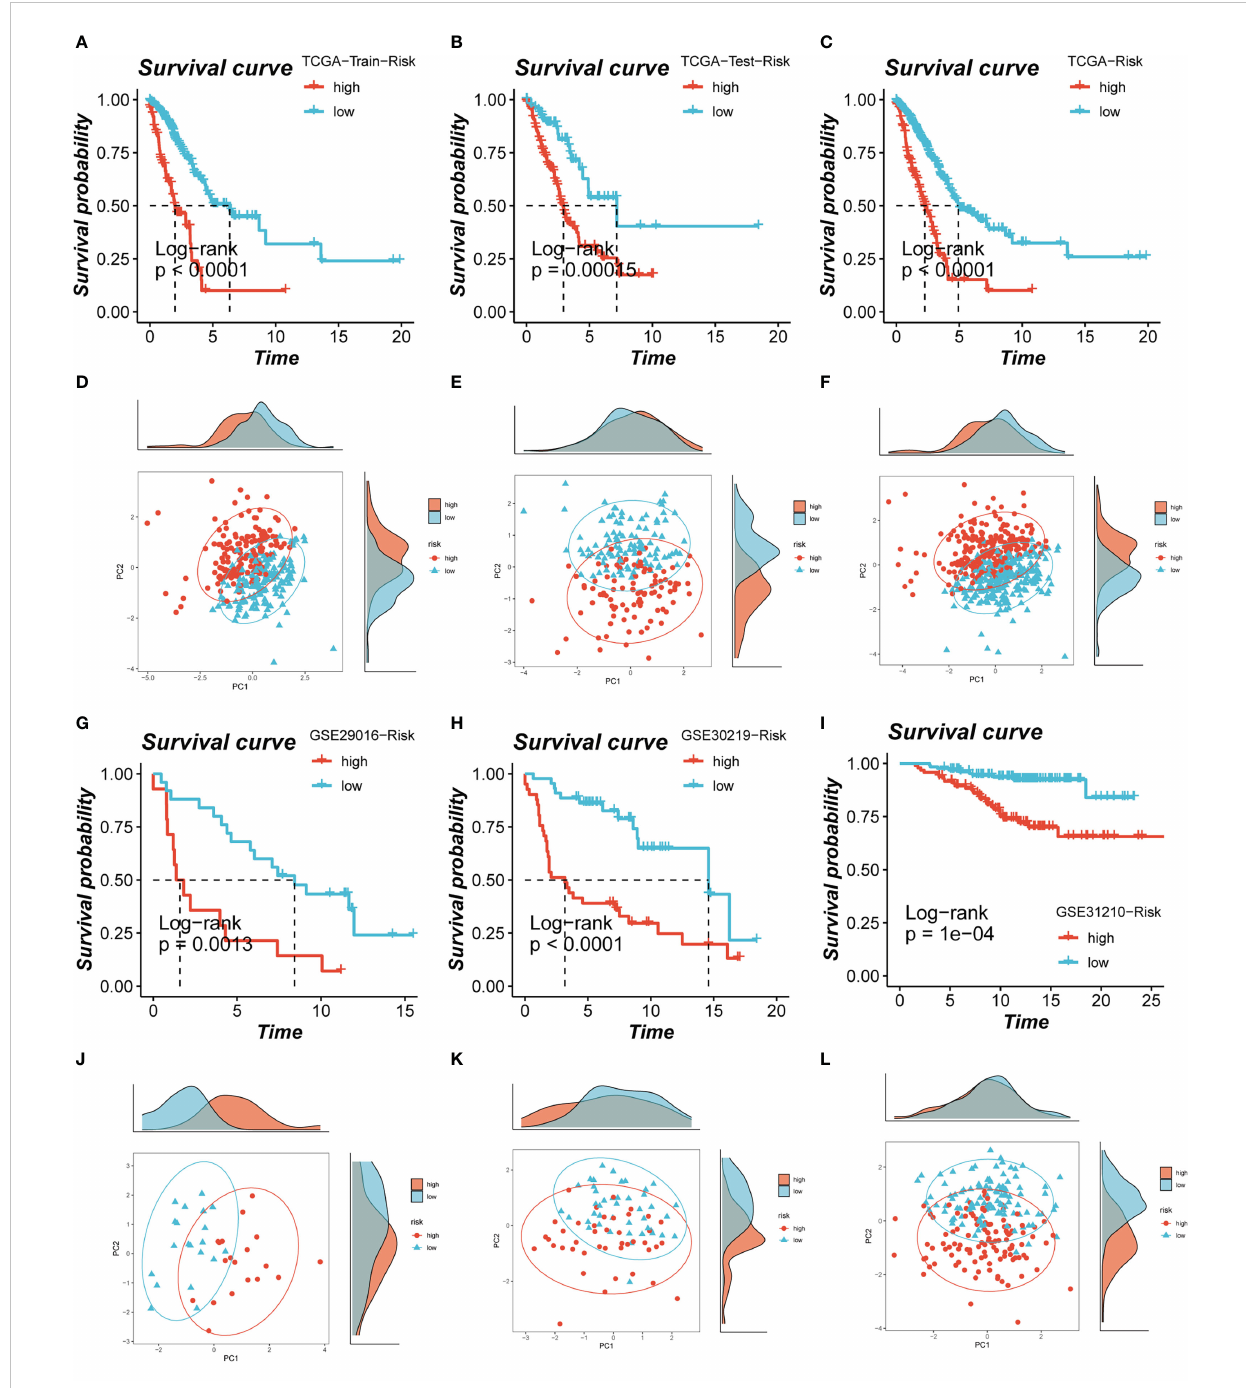
FIGURE 4 Assessment of risk models. (A-C) Kaplan-Meier survival analysis of signatures in the TCGA (train, test, and all set) datasets. (D-F) The PCA analysis was used to evaluate the distribution of the samples in the TCGA (train, test, and all set) datasets. (G-I) Kaplan-Meier survival analysis of signatures in the GEO (GSE29016, GSE30219, and GSE31210) datasets. (J-L) PCA analysis showed the distribution of samples in the GEO (GSE29016, GSE30219, and GSE31210)